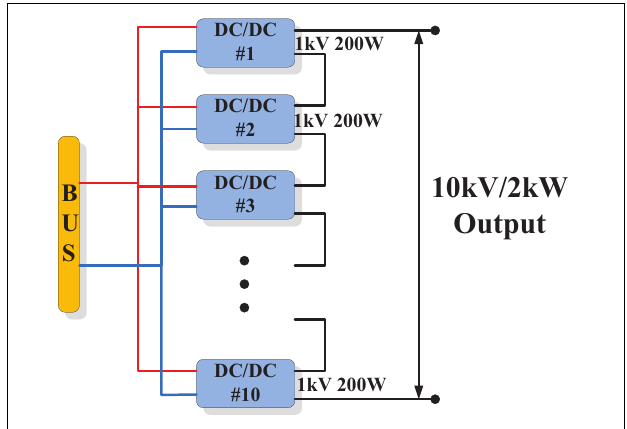
FIGURE 1 | High-voltage converter topology for space